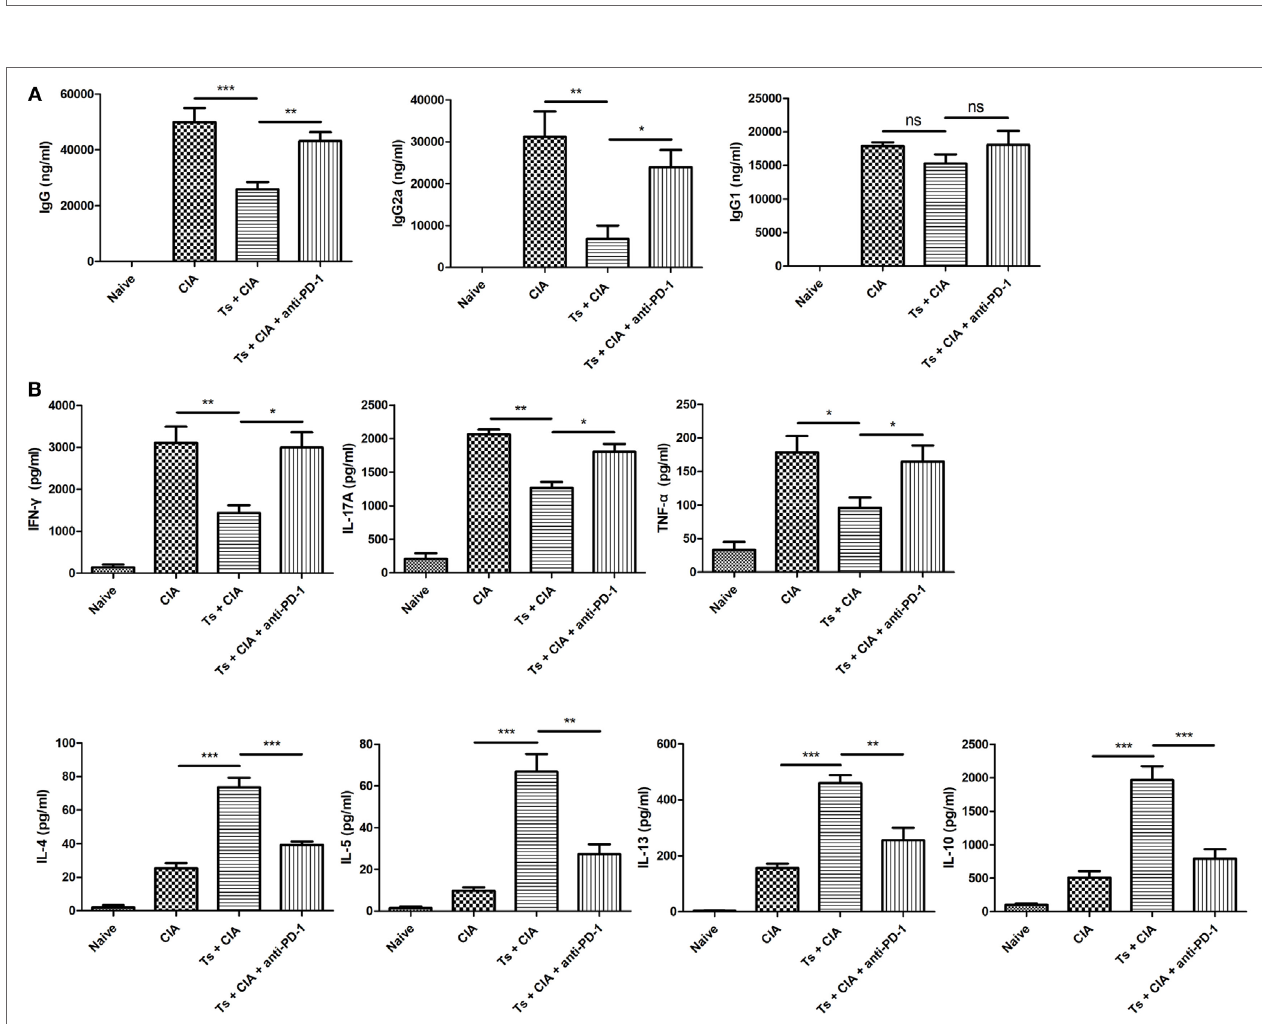
FigUre 2 | Programmed death 1 (PD-1) blockade abated Trichinella spiralis infection-induced attenuation of collagen-induced arthritis (CIA) in DBA/1 mice. (a) The regimen of study including the induction of CIA, treatment with infection of T. spiralis and anti-PD-1 antibody. (B) Hind paw of a mouse before and after induction of arthritis with bovine type II collagen (CII). Arthritic incidence (c) and total arthritic score (D) of mice from different groups ( n = 10) at different time points. (e) Hematoxylin and eosin of the representative inflamed joints in the hind paw of mice from different groups at day 50 post first CII immunization, the histological score was shown on the right (mean ± SEM, n = 6). (e) The toluidine blue staining and cartilage score (F) of the representative inflamed joints in the hind paw of mice from different groups at day 50 post first CII immunization. (a) Naïve untreated control, (b) CIA, (c) Ts + CIA, (d) Ts + CIA + anti-PD-1. The bar graphs on the right side (e,F) show the histopathological scores for each group given as mean ± SEM ( n = 6 mice per group). Statistical significance is determined by Student’s t -test for single comparison. ** P < 0.01 and *** P < 0.001 (one-way analysis of